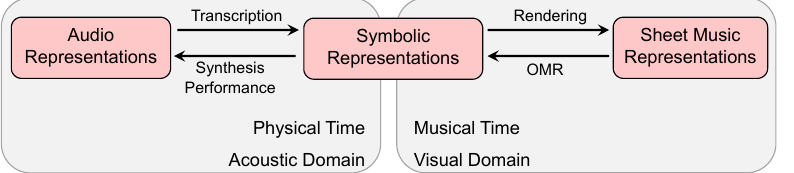
Figure 4. Illustration of three classes of music representation and their relations (from [1], Figure